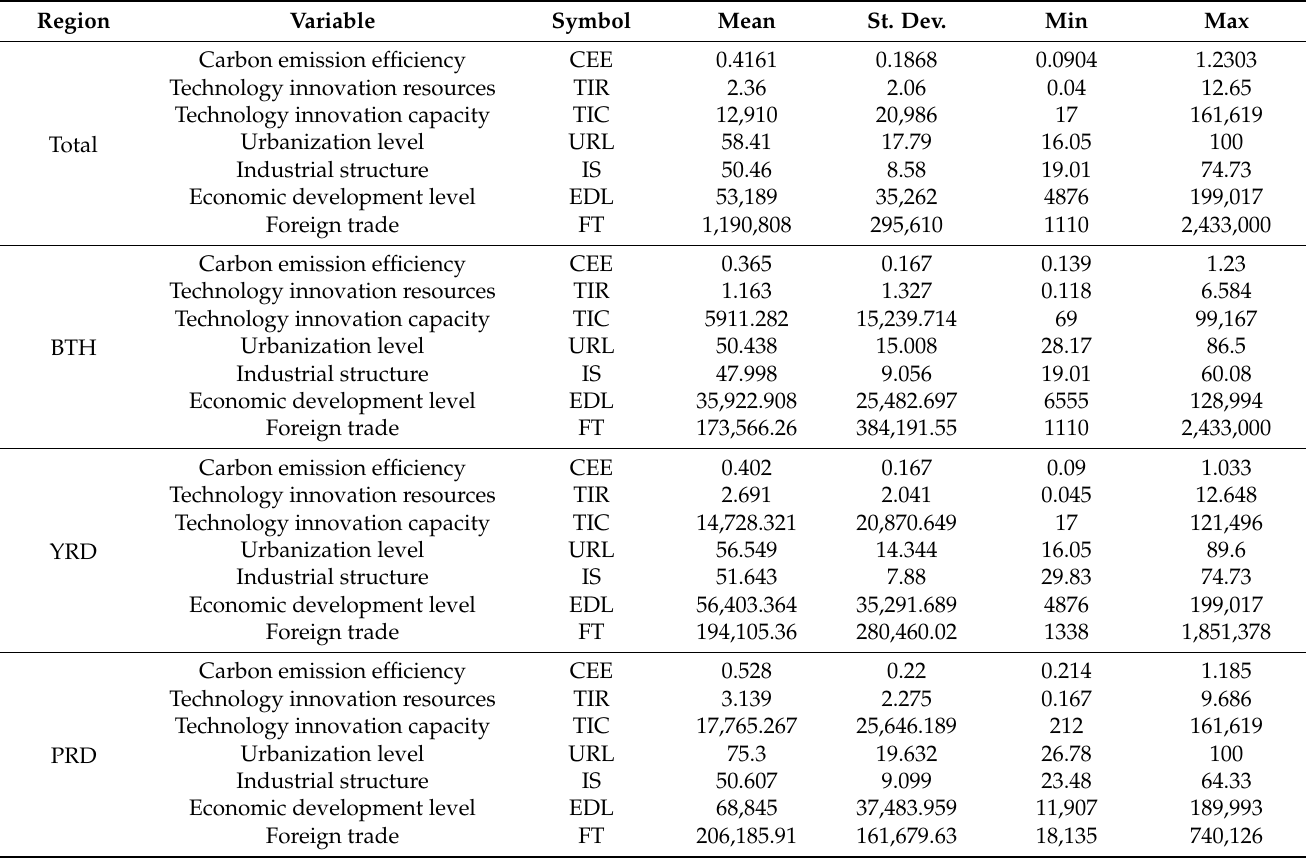
Table 3. Descriptive statistics of driving variables of